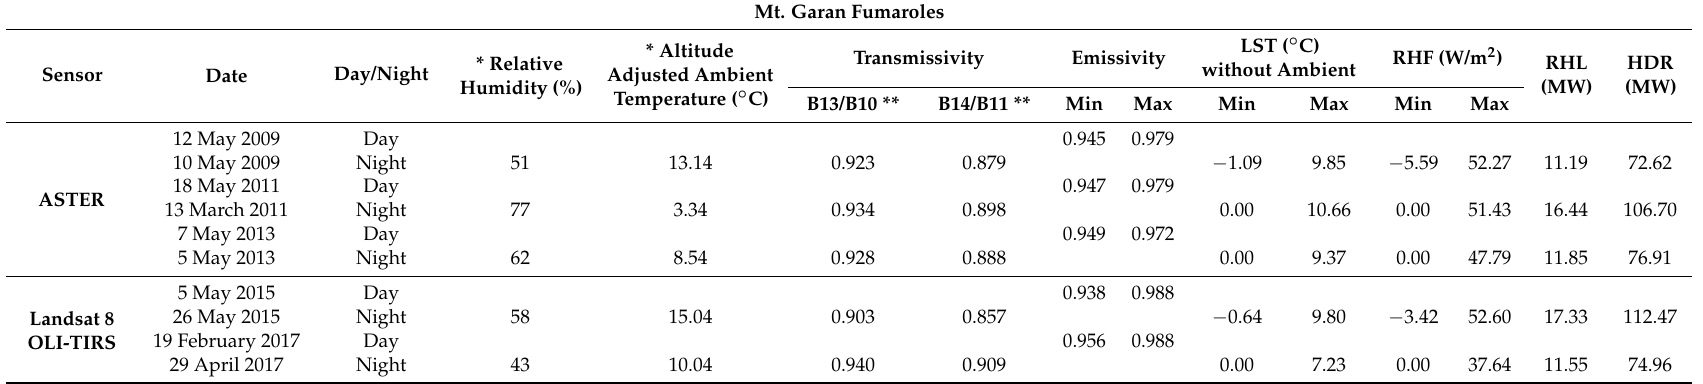
Table 3. Summary of heat loss at the Mt. Garan fumaroles from 2009 to 2017 based on ASTER and Landsat 8 TIRS images. Ambient temperature and relative humidity were recorded at Oita station (AMeDAS) and later adjusted for variation with altitude using the International Standard Atmospheric method after Talay (1975). Mt. Garan